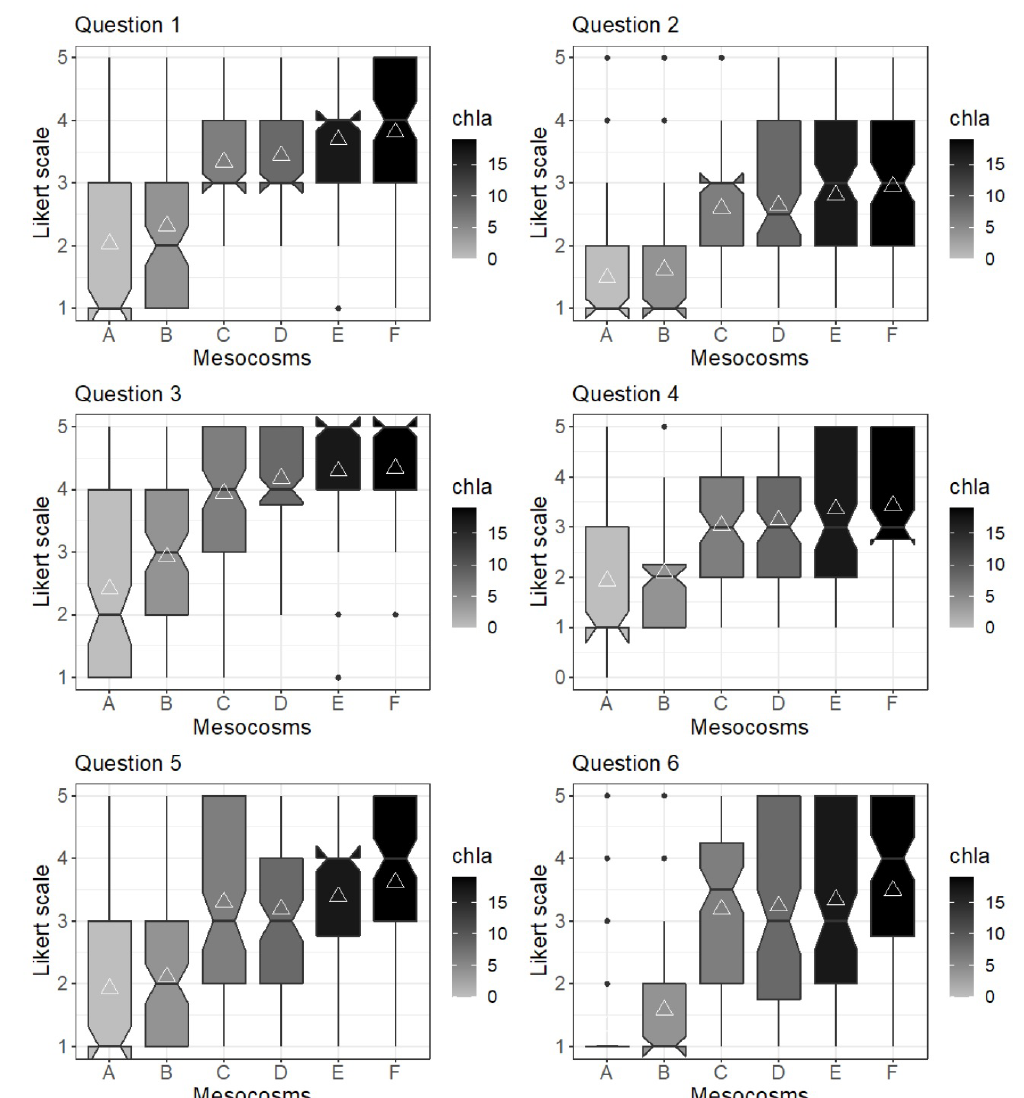
Figure 2. People’s perception of the water quality indicated by mean (triangle) and dispersal of each question (Likert scale), for each mesocosm in the in-situ experiment. The concentration of Chlorophyll-a (chla) of each mesocosm is represented on a gradient scale. The Likert scale varies from 1 (nice feeling about the water quality) to 5 (disgusting feeling about the water quality). The chlorophyll-a concentration in mesocosms varies from 0 (mesocosm A) to 18 g/L -1 (mesocosm μ